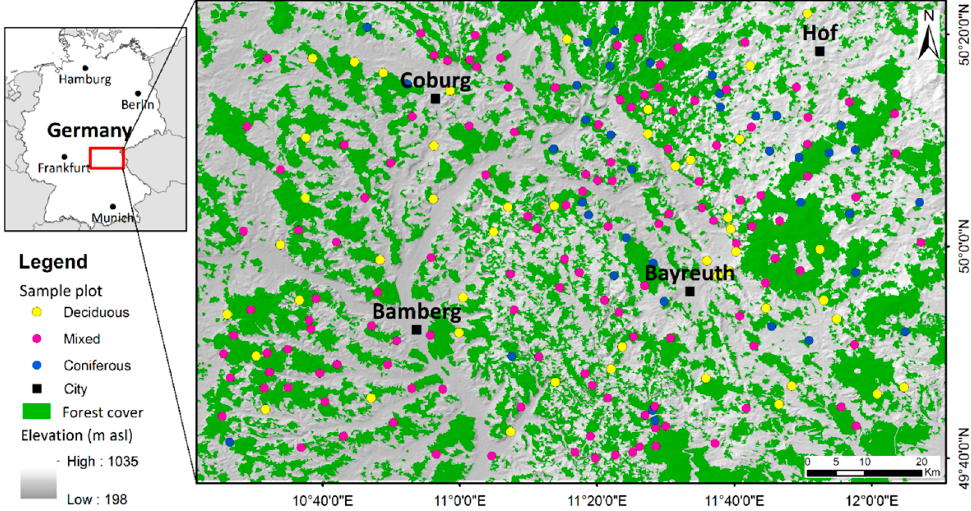
Figure 1. Location of the 218 plots in the three forest types. Forest cover based on digital landscape model (DLM) 1:250,000 (DLM250), © GeoBasis-DE/BKG 2020.